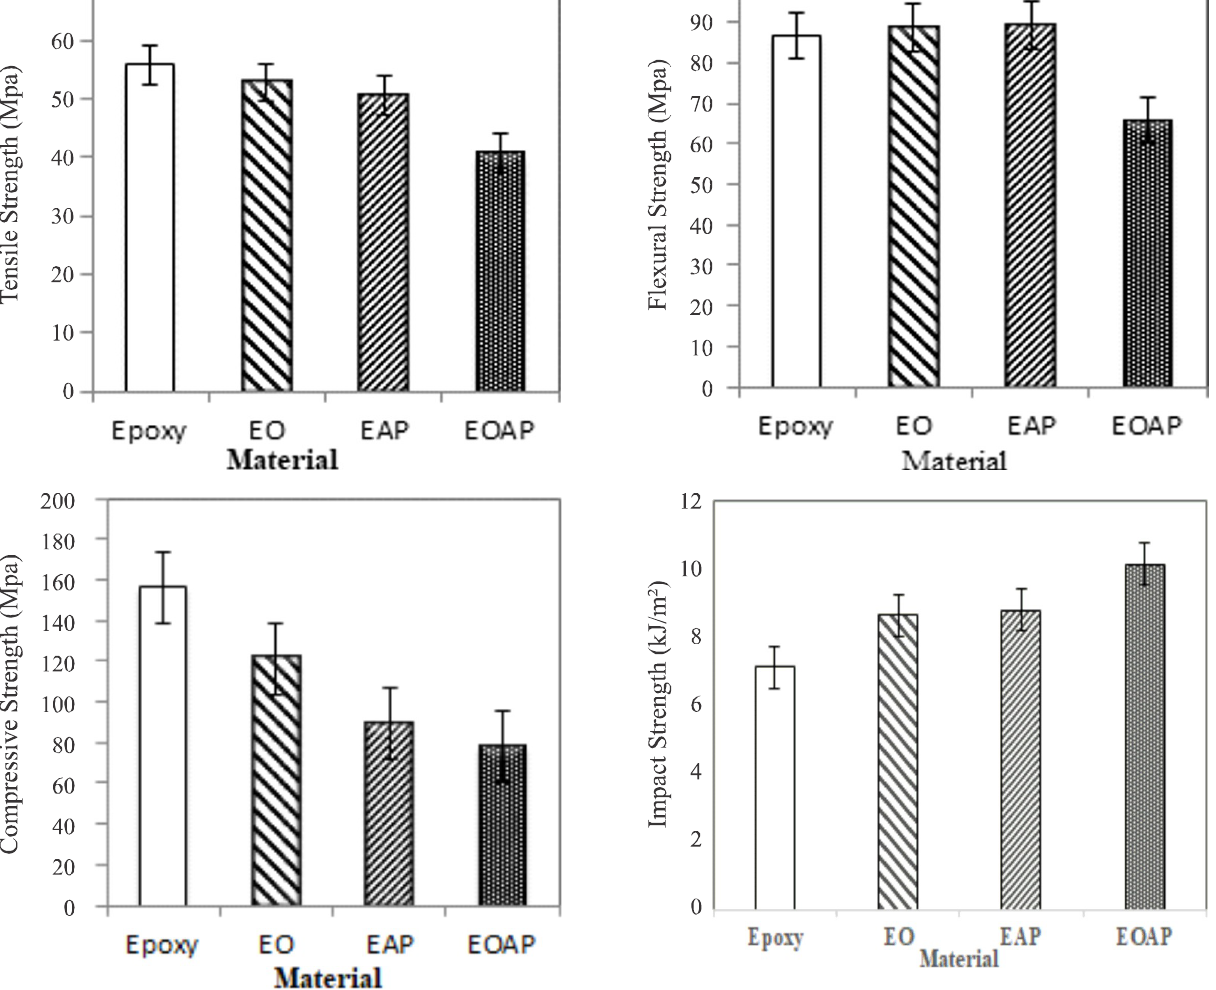
FIG. 9. MECHANICAL STRENGTH OF POLYMER EPOXY MATERIALS: NEAT EPOXY; EPOXY/EPOXIDIZED LINSEED OIL (EO); EPOXY/SB O 9 PHR /CHLORINATED PARAFFINS 11PHR (EAP); EPOXY/ EPOXIDIZED LINSEED OIL/SB 2 3 CHLORINATED PARAFFINS 9PHR